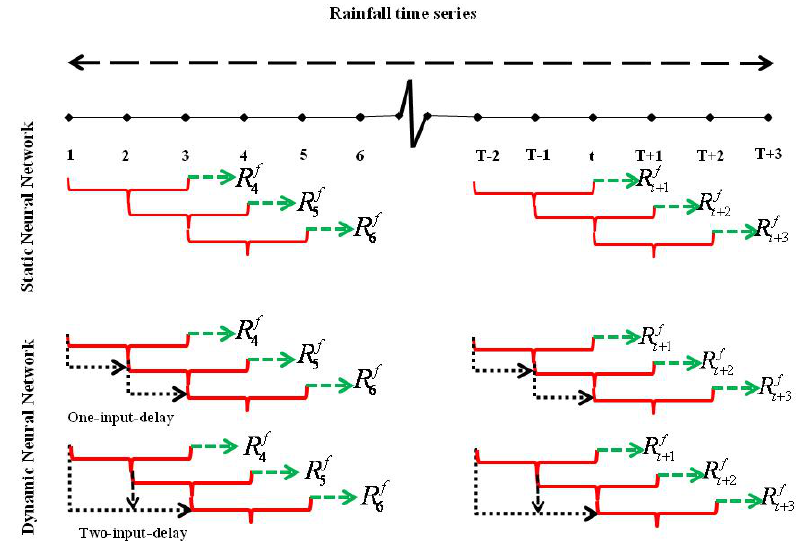
Figure 10 Model time line index with sliding window method Fig. 10. Model time line index with sliding window